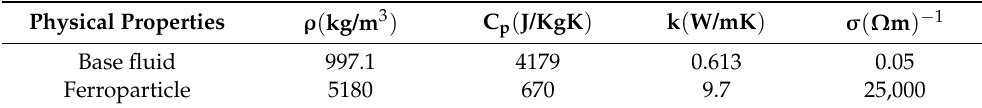
Table 1. Values of the physical properties ([25,35]).